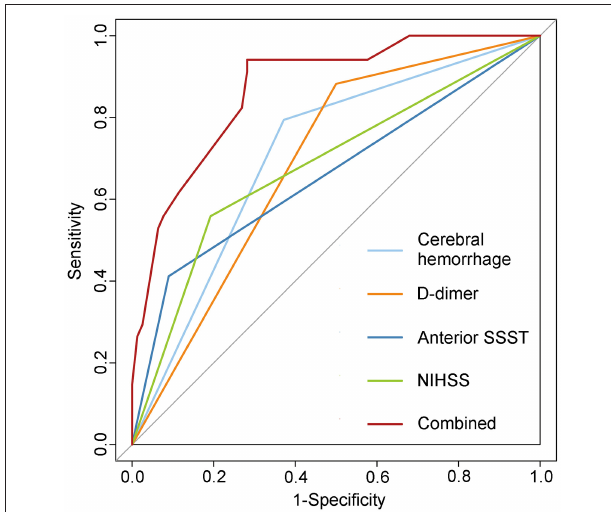
FIGURE 3 | Receiver operating characteristic (ROC) curve of the predictive model for early onset seizures. Combining four predictive factors further improved the predictive capacity as seen in the logistic regression model. SSST, superior sagittal sinus thrombosis; NIHSS, National Institute of Health Stroke